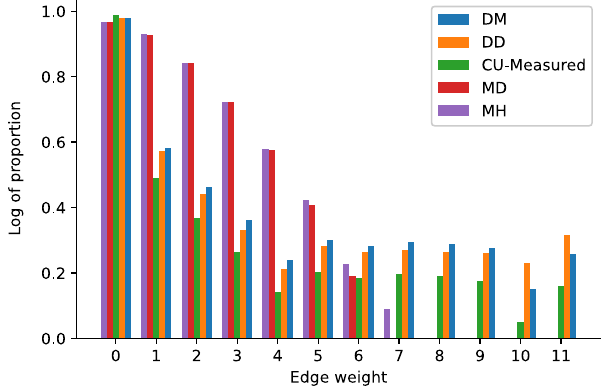
FIG. 7. Distribution of edge weights in the Fall 2020 CU Boulder thermal physics course and in simulated networks. The height of the bars is the log of the ratio of the number of links of a particular weight to square of the number of nodes, i.e., the total number of ordered pairs of